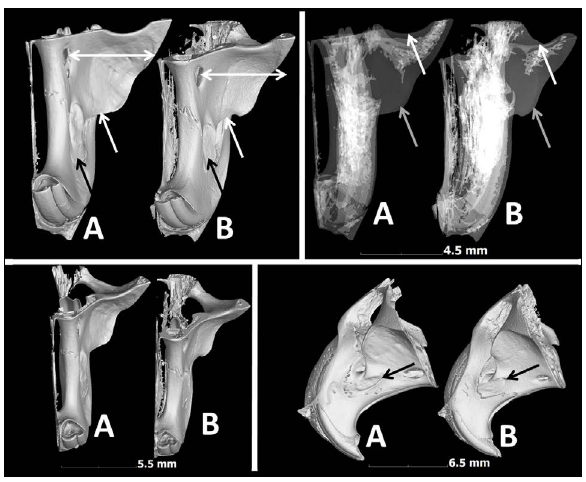
Figure 4: Comparison of maxilla of (A) indeterminate Elandspad Otomys (EPF–bulk–1) with (B) cf. O. karoensis (DHC–10–3): top left, right maxilla ventral view; top right, view of same with enhanced transparency; bottom left, view of intraorbital foramina; bottom right, left premaxilla. Arrows indicate areas of morphological difference between the two